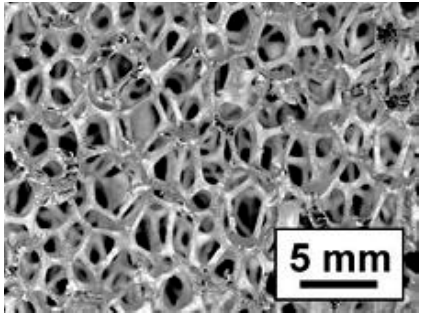
Figure 2. Close-up of an aluminium foam sample attached to a model condenser tube where the cells’ structures induce a tortuous flow